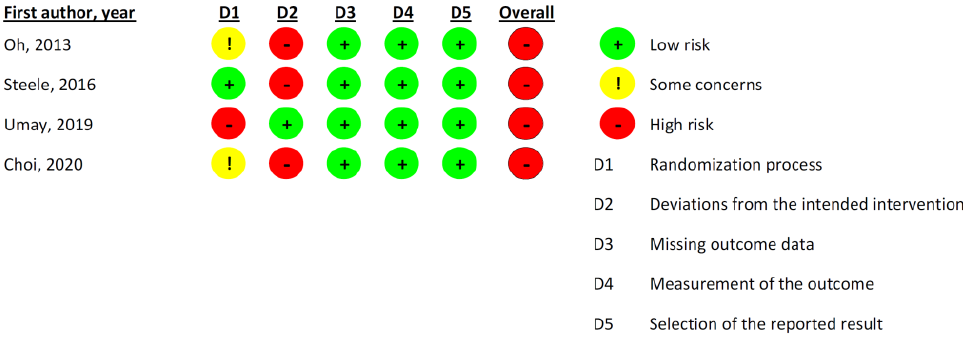
Figure 2. Risk of bias [12,13,25,28].